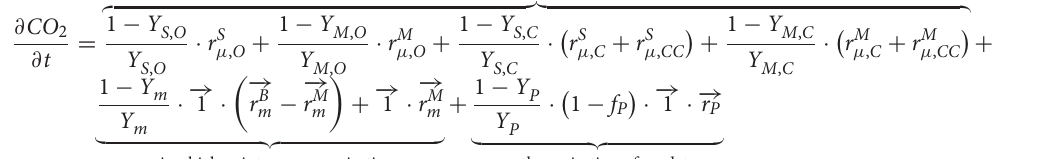
Formation of carbon dioxide (CO 2 ) results from